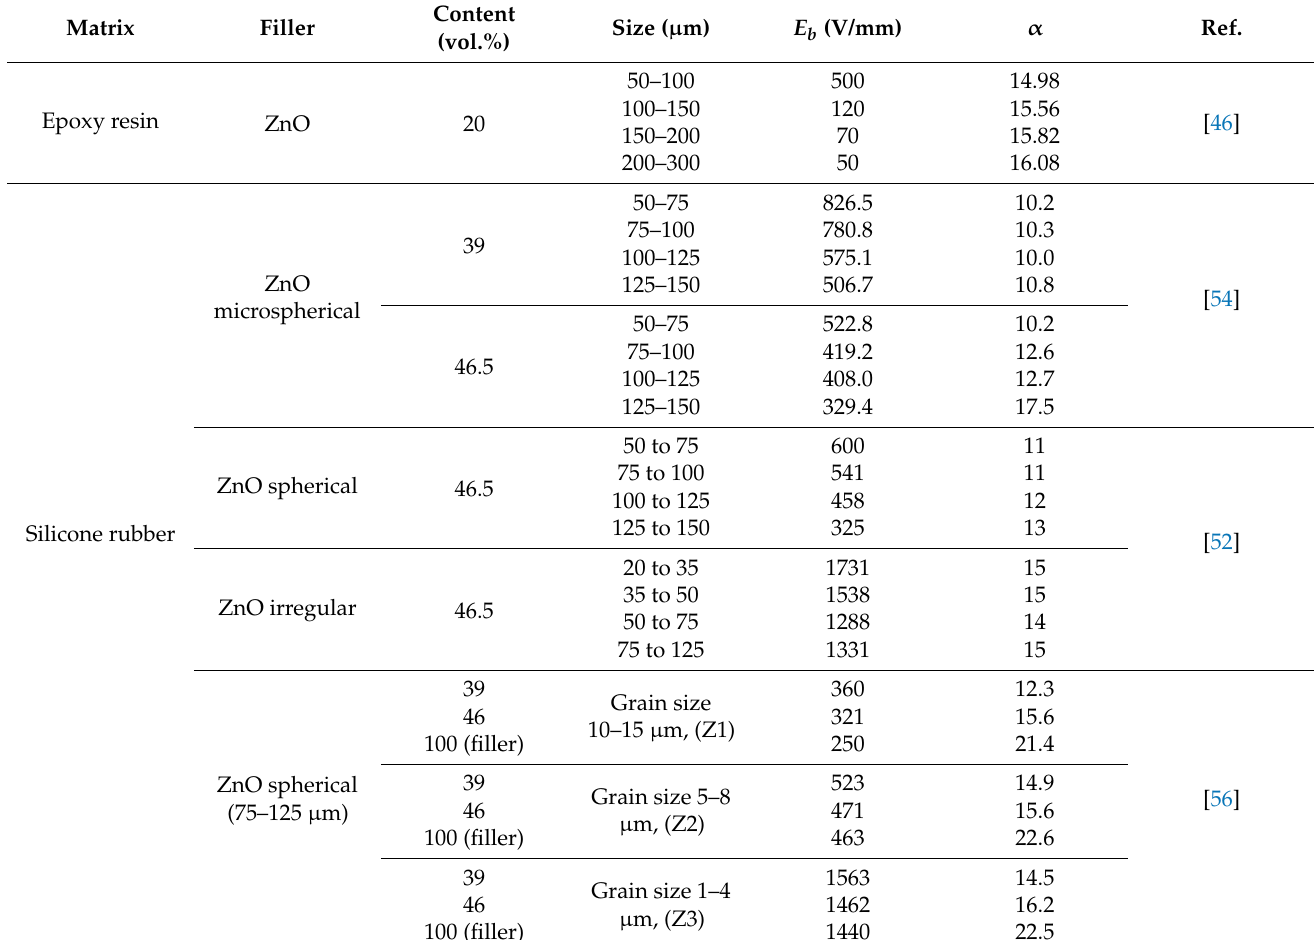
Table 5. Nonlinear properties of composites involving ZnO as a filler: effect of filler size.